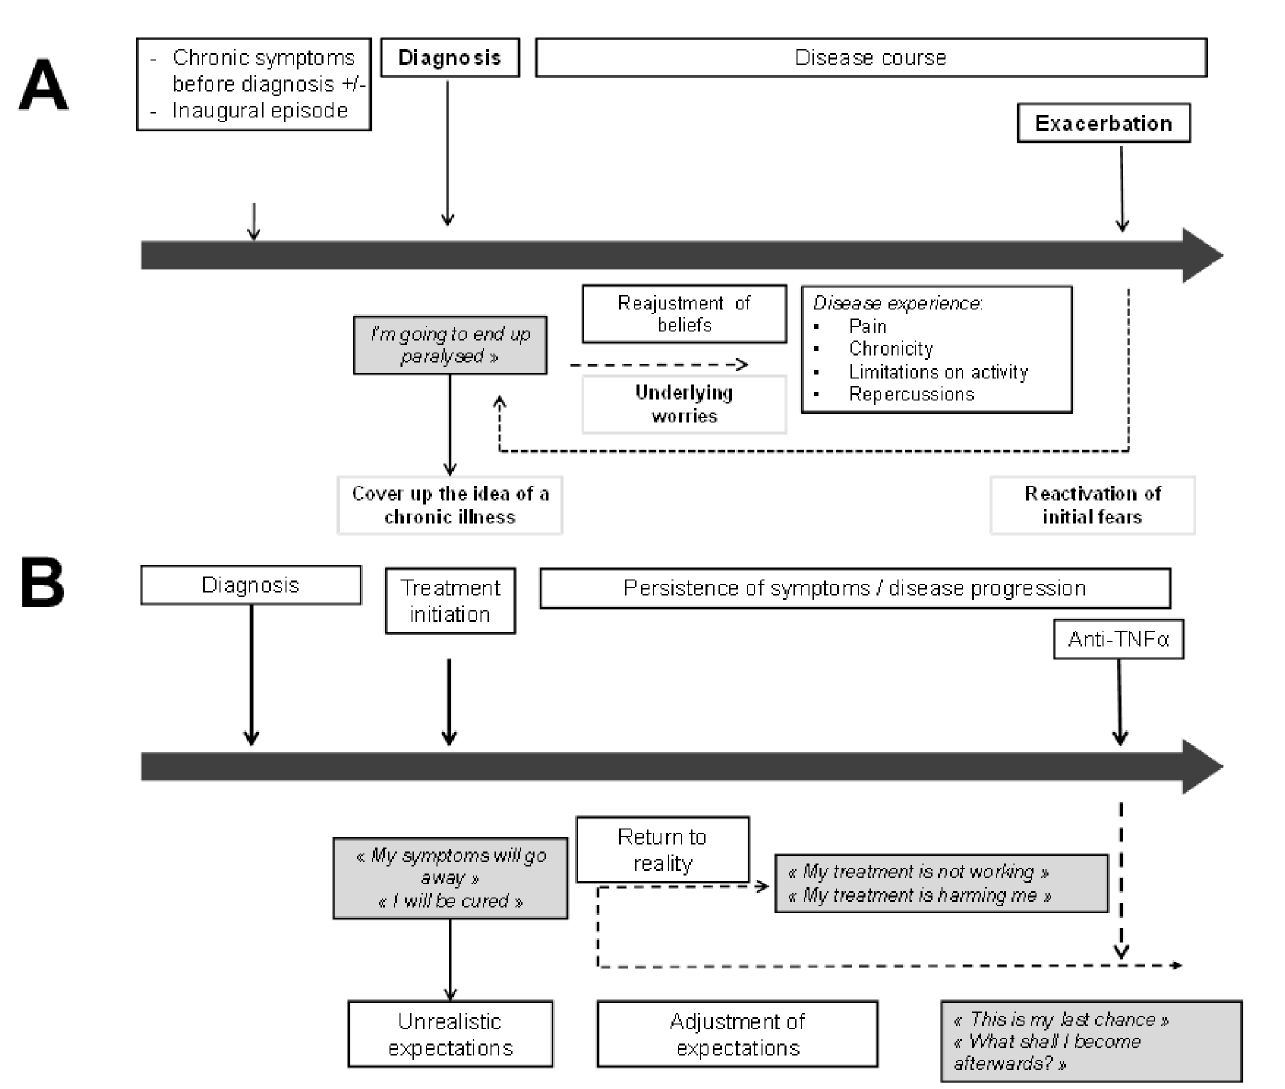
Fig. 2. Evolution of beliefs and apprehensions over the disease course. A: disease perceptions. B: treatment